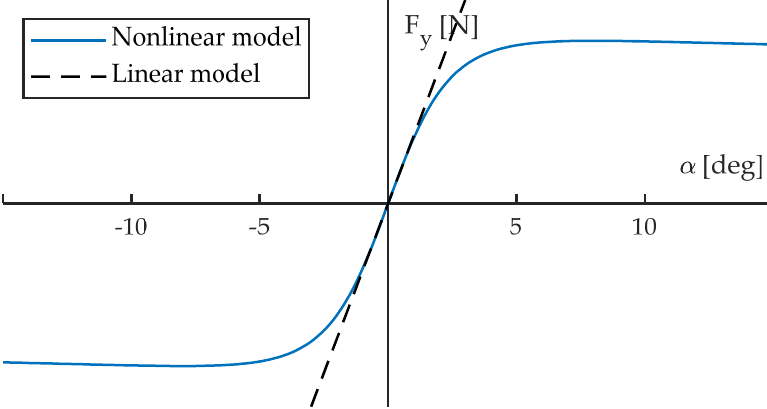
Figure 1. Pure lateral force against slip angle. Linear and non-linear regimes.